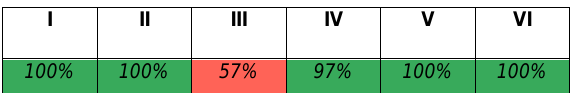
Table 2 | Performance of the classification of movements